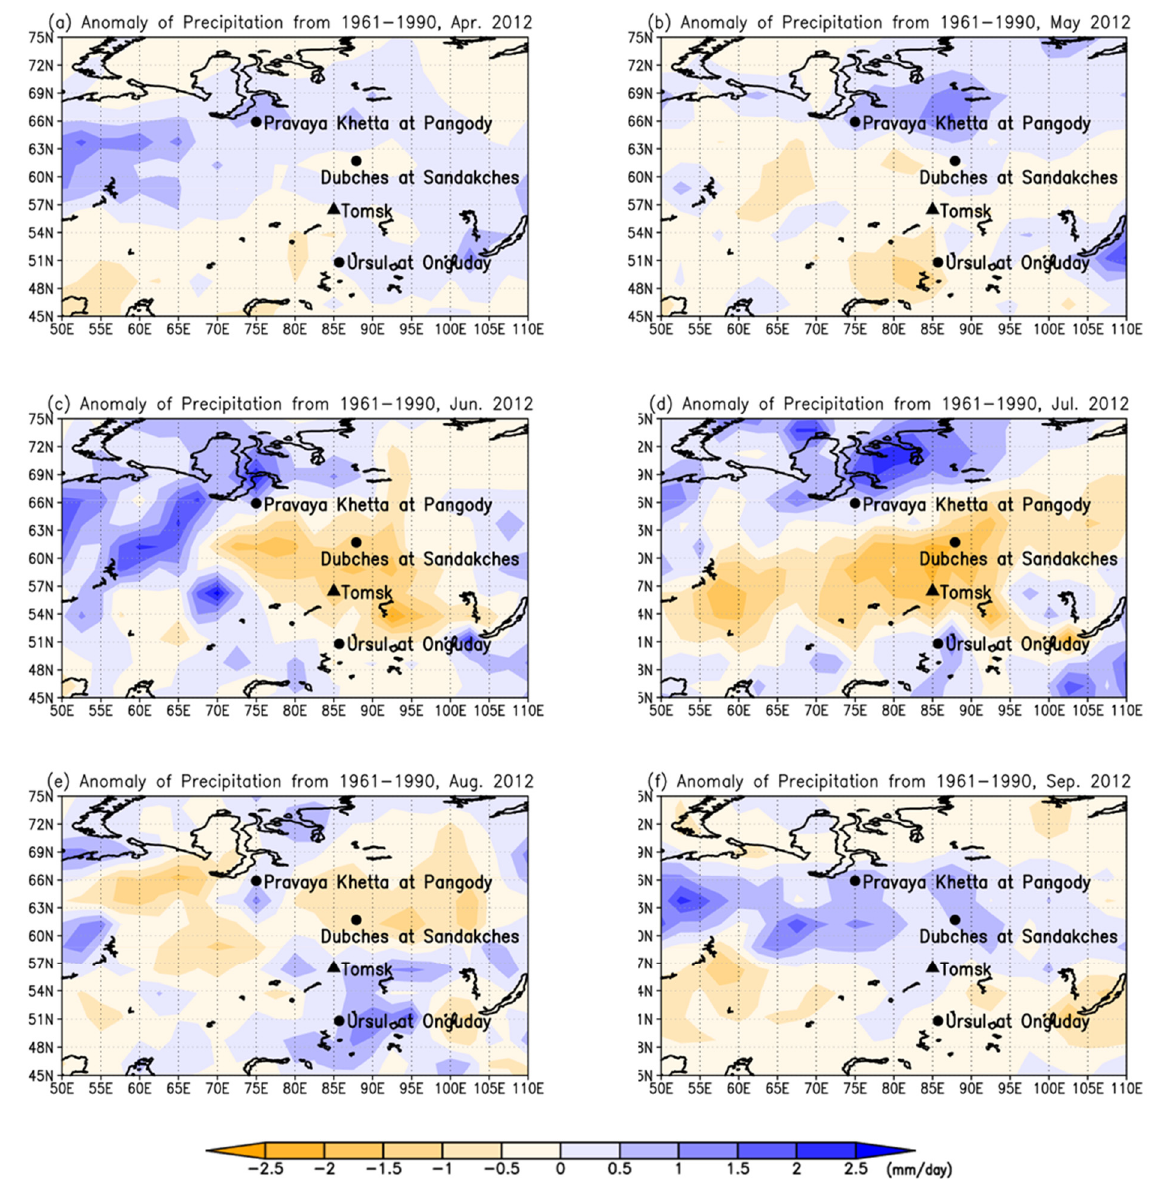
Figure 4. Distribution of precipitation anomaly from 1961 to 1990 in 2012, based on CMAP [18]. ( a ) April, ( b ) May, ( c ) June, ( d ) July, ( e ) August, and ( f ) September. Black circles are experimental basins, whereas black triangle represents Tomsk.